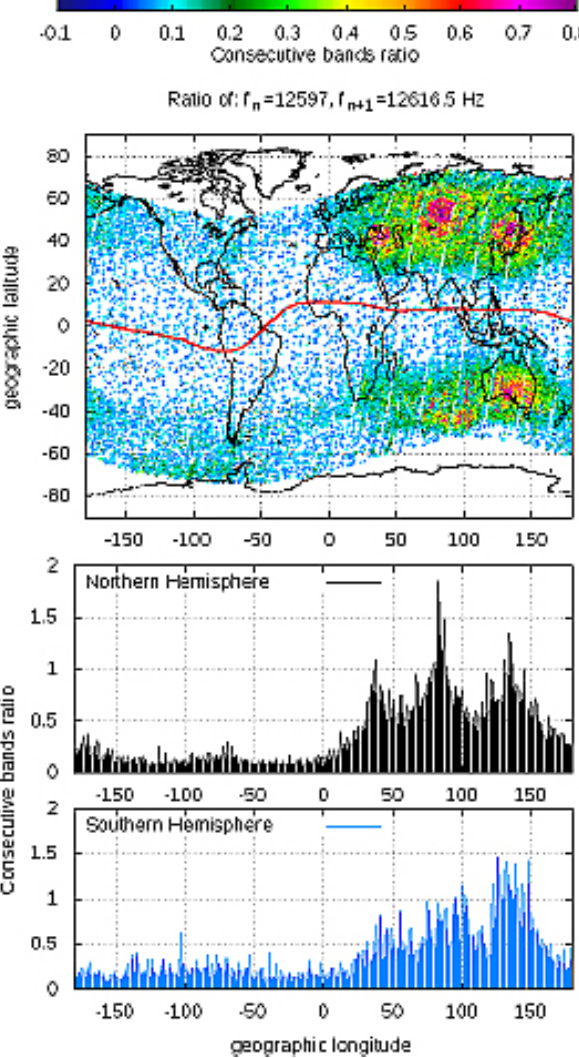
Fig. 6. Average distribution of electric power in the 15–25kHz range measured during night passes during 3yr (2007–2009). The corresponding transmitters are indicated by their international code. The two black lines indicate the L = 2 contours in the Northern and the Southern hemispheres.